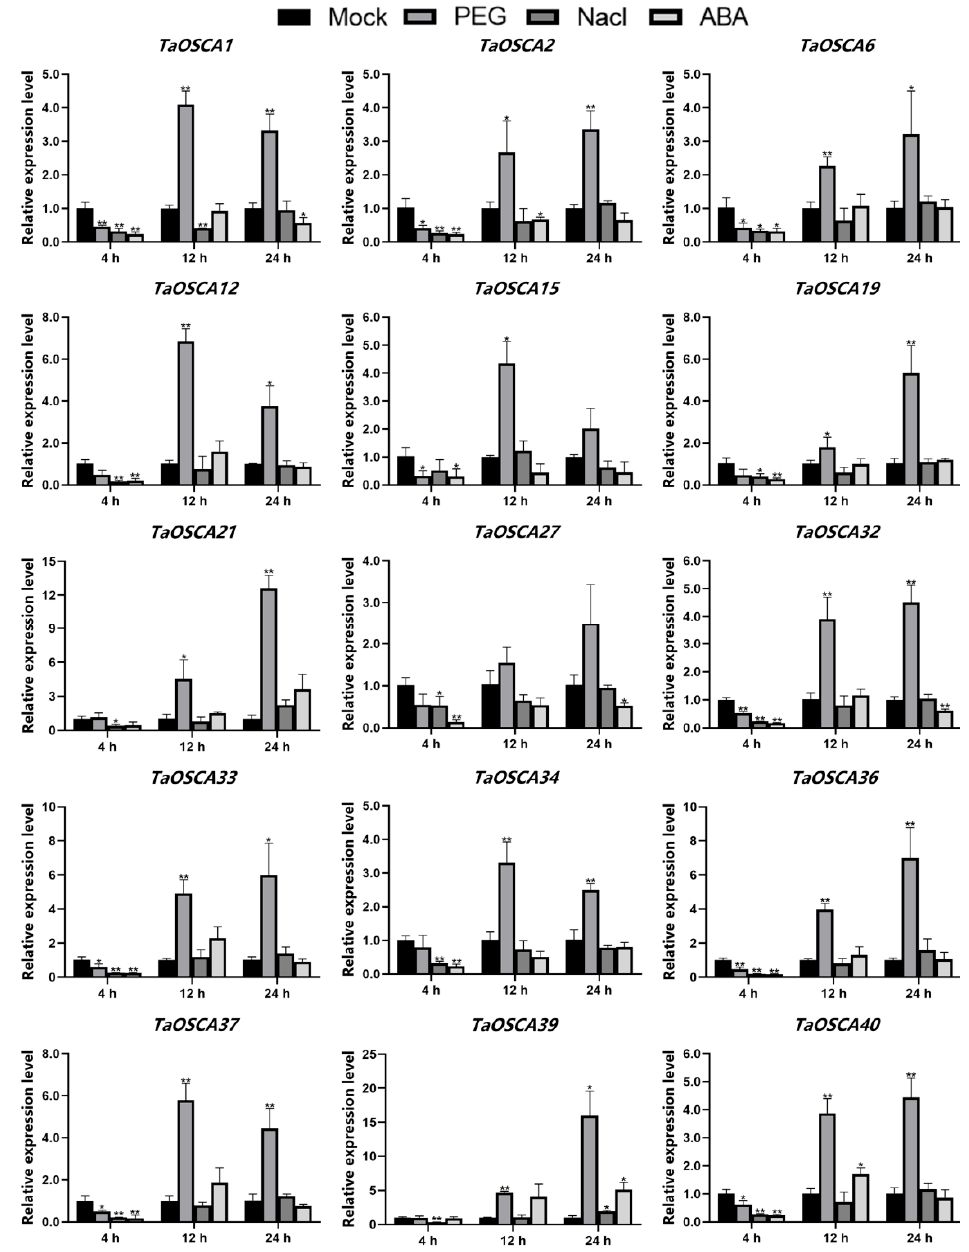
Figure 6. Expression analysis of TaOSCAs under PEG, NaCl, and ABA treatment. Gene expression was normalized to control unstressed expression level, which was assigned a value of 1. Data represent average of three independent experiments ± SD. Standard errors are shown as bars above columns. * denotes significant difference at p < 0.05, and ** denotes significant difference at p < 0.01 according to the Student’s t -test.